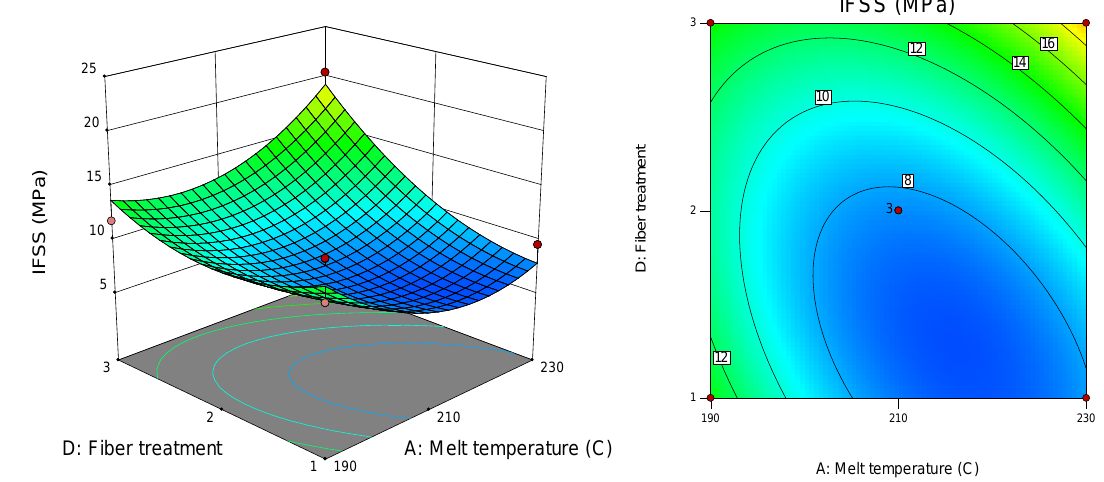
Figure 12. Interaction effect between melt temperature and fibre treatment on IFSS.